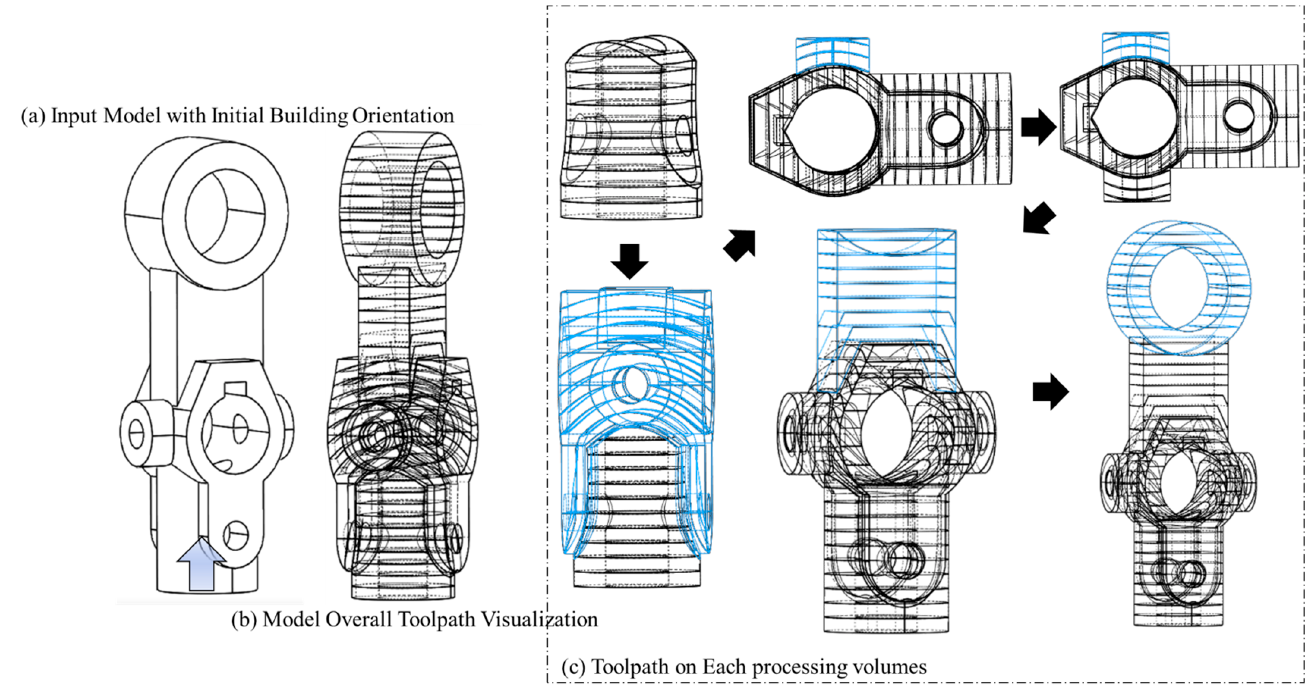
Figure 13. Trajectory accumulation on model with second defined initial building orientation for model (a).